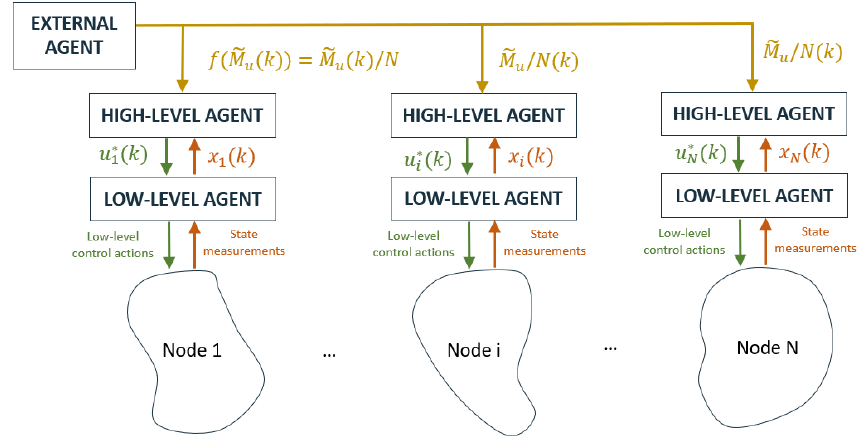
Figure 4. Generic decentralised MPC